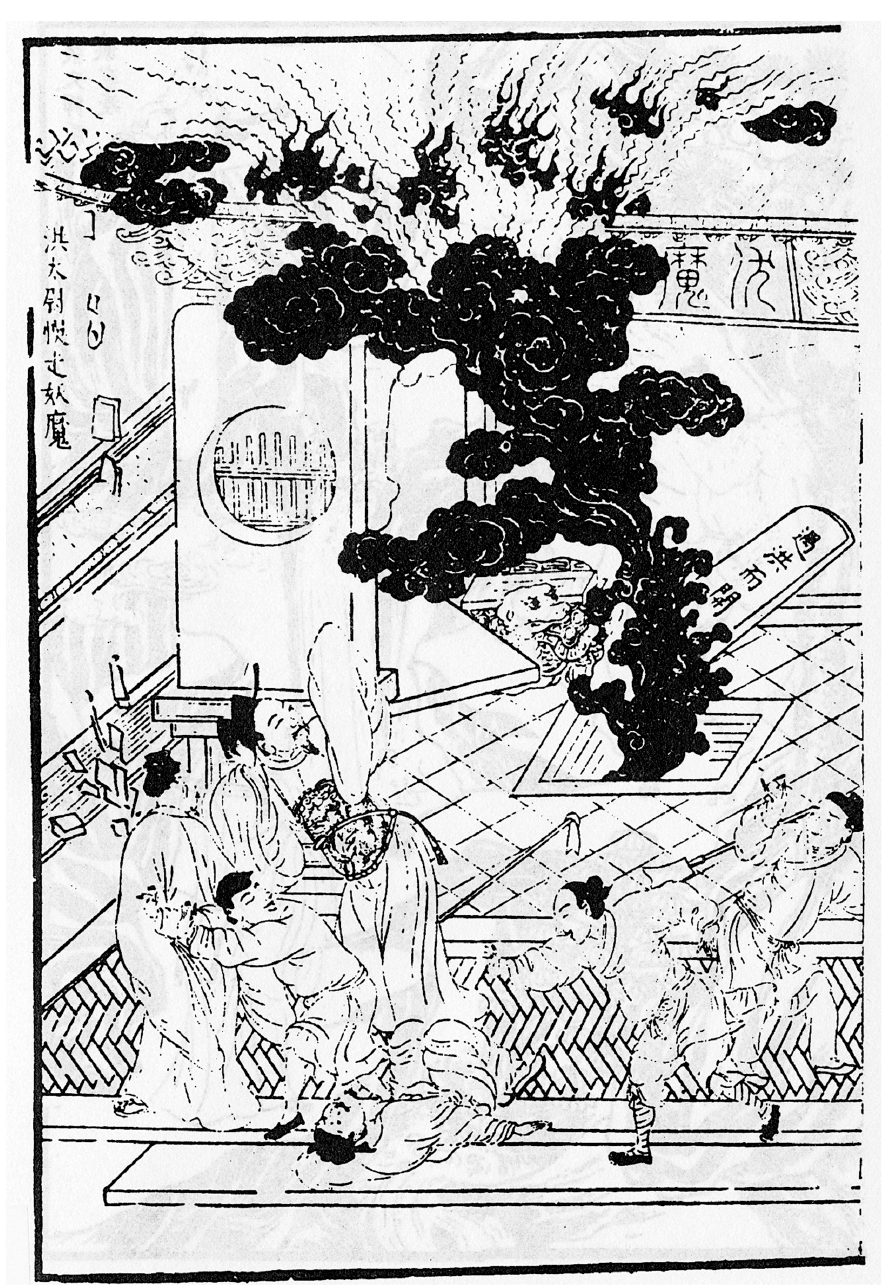
Figure 7. Black miasma escapes the demon prison. From Shuihu zhuan , Rongyu Tang edition.